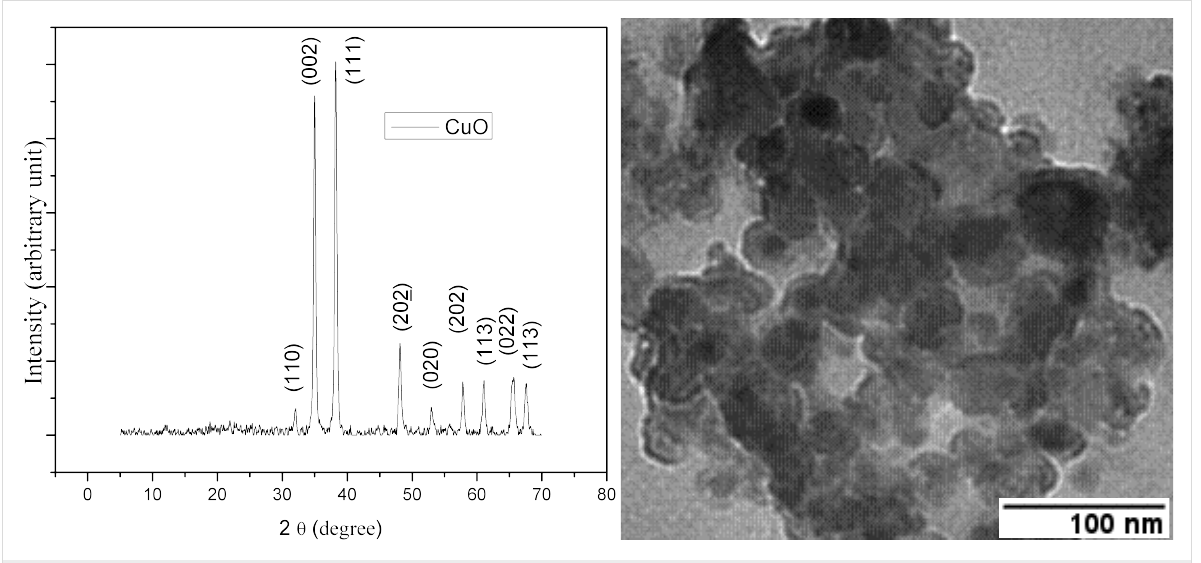
Figure 1: Powder X-ray diffraction pattern and TEM image of nano CuO (fresh).